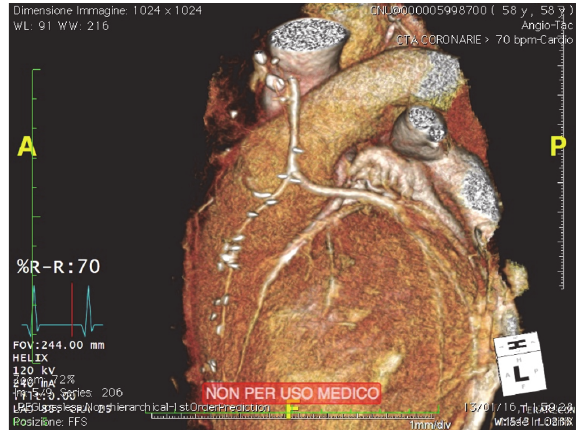
Figure 2: 3D reconstruction of the coronary CT scan, showing a patent LITA to LAD and a composite Y-graft with SV from LITA to obtuse marginal